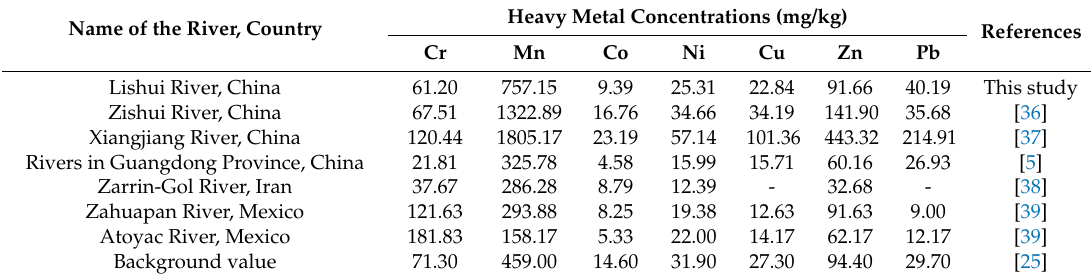
Table 3. Heavy metal concentrations in the sediments from the Lishui River and other selected rivers. Name of the River,